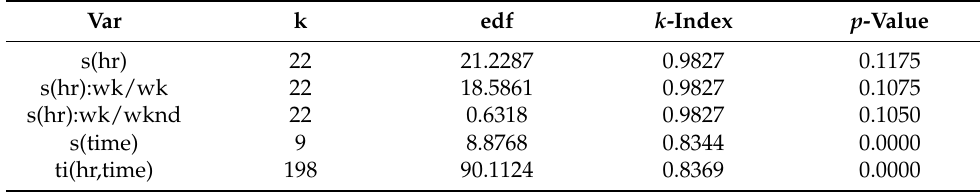
Table 11. K-check extended non-spatial GAM with a spatial covariate.